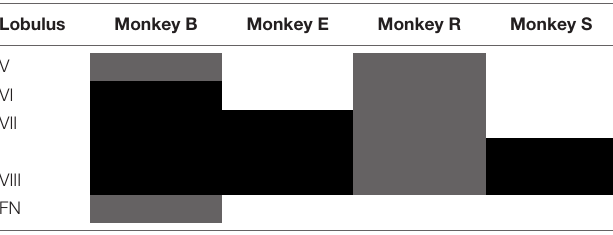
TABLE 1 | Extent of lesion for individual